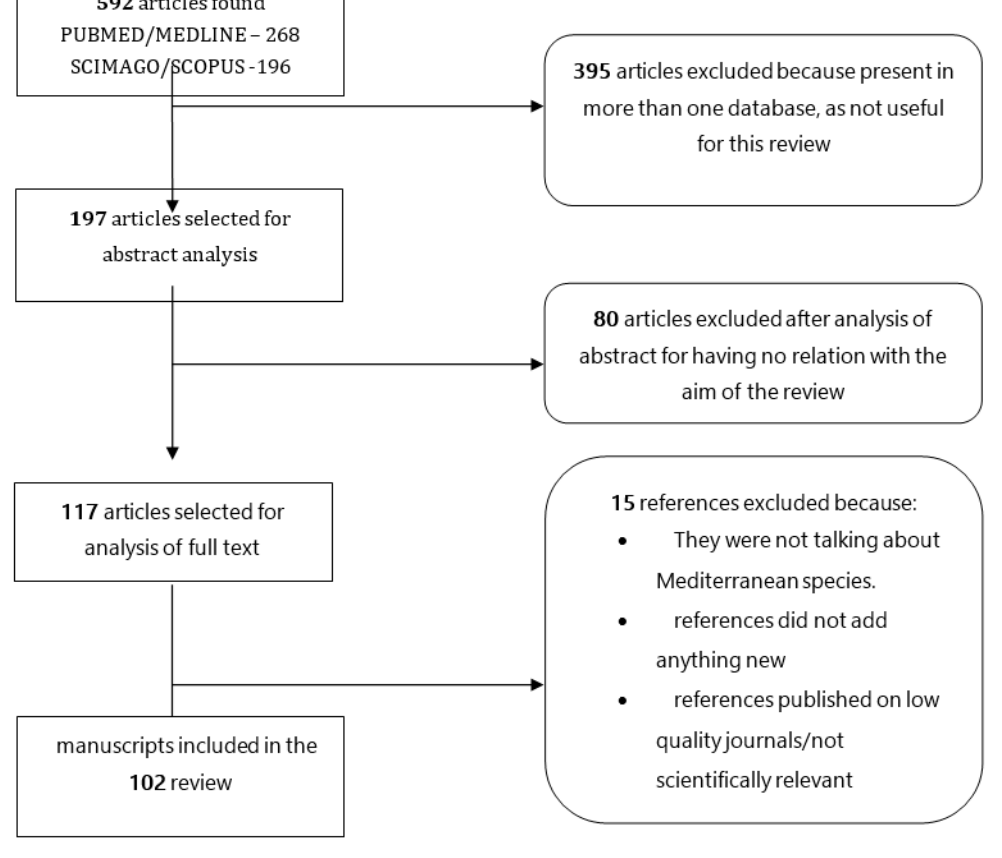
Figure 1. Article selection flowchart.